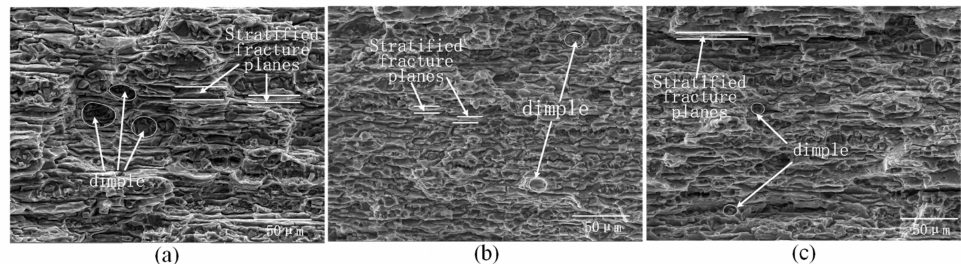
Figure 7. SEM morphologies of fatigue stability propagation regions of 7075 aluminum alloy at di ff erent prebending radii ( S max = 260 MPa). ( a ) 1500 mm; ( b ) 1000 mm; ( c ) 500 mm.